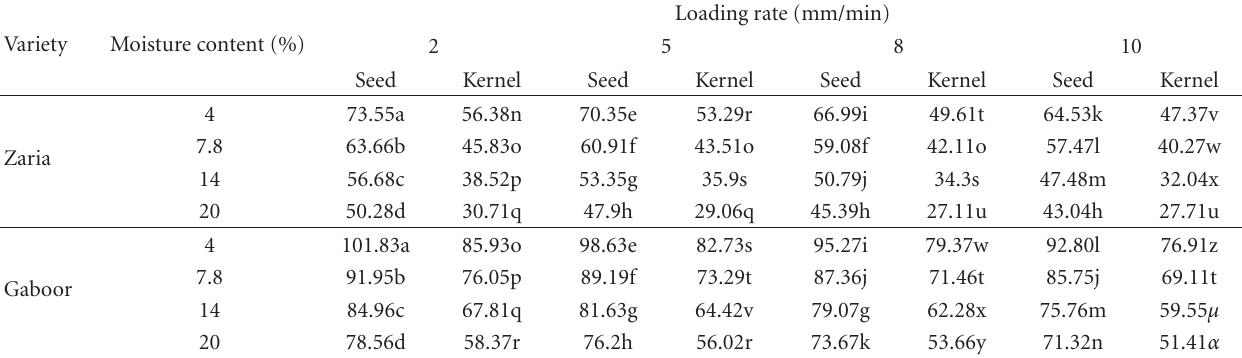
Table 3: Mean comparison of elastic modulus (Mpa) of pumpkin seed and its kernel considering interaction e ff ect of loading rate, variety, and moisture content.